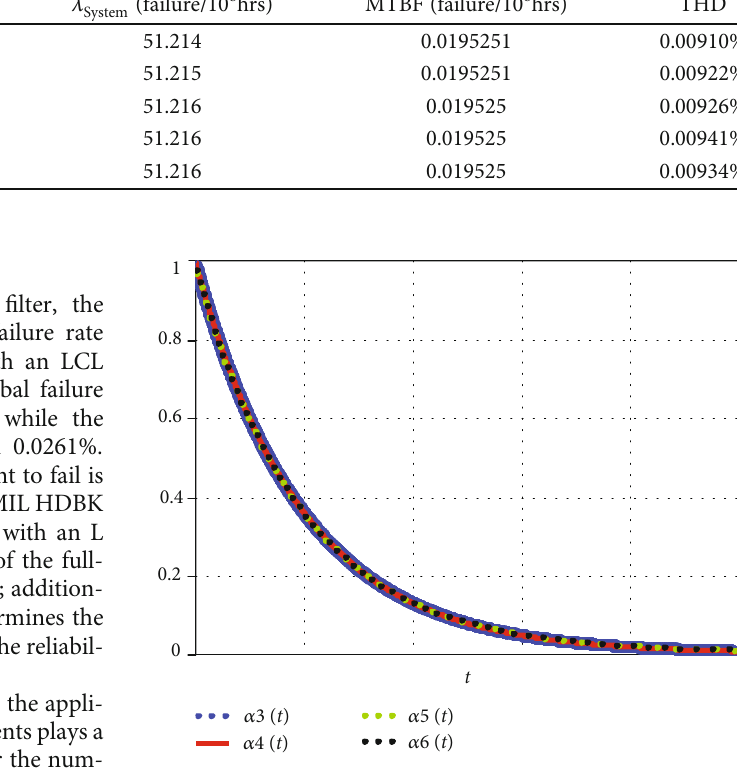
Figure 11: Comparison of reliability for di ff erent values of the components of the LCL fi